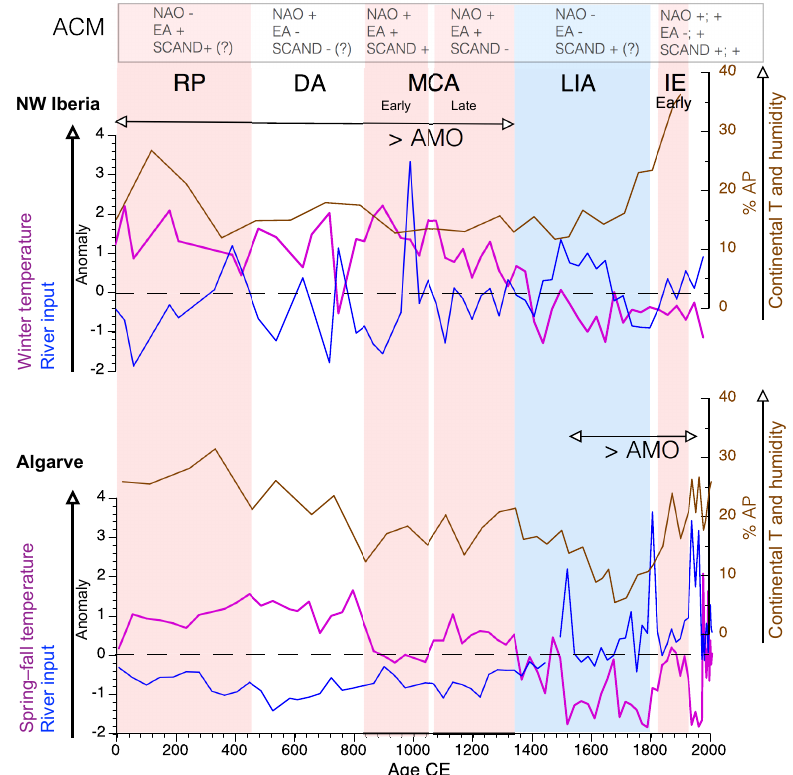
Figure 5. SST and river-input ([ n -alk] stacks for NW Iberia (Galiza, Minho and Porto) and continental T and humidity conditions extracted from arboreal pollen (%AP) at Minho are compared to the Algarve SST and [ n -alk] anomalies (for easier comparison) and %AP. Pink bars mark the warmer periods (RP; MCA; Industrial Era – IE), and the blue bar marks the cold LIA. Periods of increased AMO that impact on either IP region are marked by AMO. The dominant state of the ACMs in the North Atlantic for the major climatic periods of the last 2000 years is depicted at the top of the figure (NAO; EA; SCAND). The consecutive negative and/or positive signs given for IE in the top bar (ACM) correspond to the early IE, 1850–1970, and the late IE, after